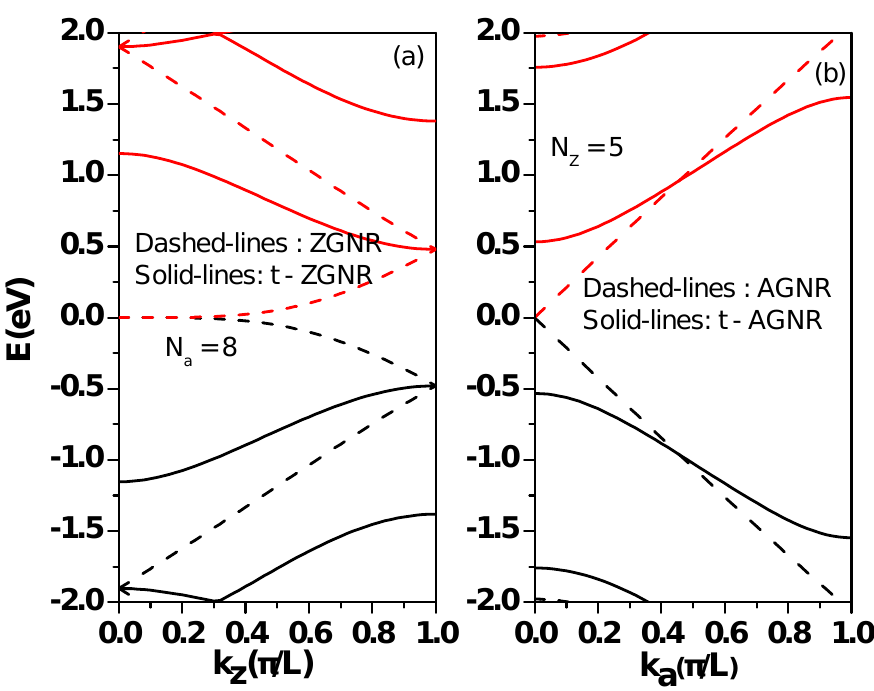
Figure A2. ( a ) Subband structures of t-ZGNR superlattice with a unit cell of length L characterized by N a = 8 and N z = 8 (solid lines) as depicted in Figure 1b, and corresponding ZGNR (without texture) of the same length of unit cell (dashed lines). ( b ) Subband structures of t-AGNR superlattice with a unit cell characterized by N z = 5 and N a = 8 (solid lines) as depicted in Figure 1d, and corresponding AGNR (without texture) of the same length of unit cell (dashed